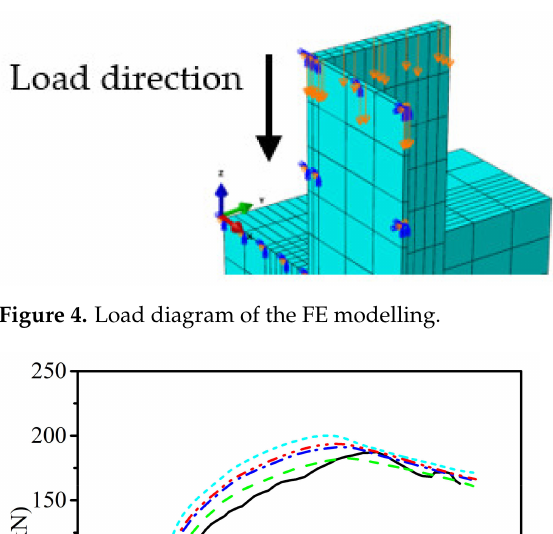
Figure 3. Boundary conditions and loading surface.